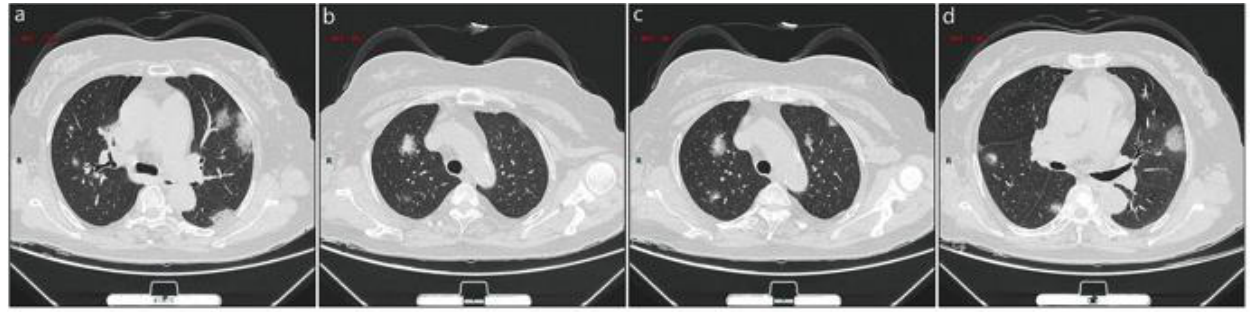
Figure 5: Atypical CT / X-ray imaging manifestation (case 2). A 56 years old female with fever for 3 days. Laboratory test: decreased total protein (54.0 g/L),decreased albumin (35.5 g/L),decreased globulin (18.5 g/L), normal white blood cells (4.87 × 10 9 /L), decreased lymphocytes percentage (10.1%), decreased lymphocytes (0.49 × 10 9 / L), decreased eosinophil count (0 × 10 9 /L)), decreased eosinophil count percentage (0%). Imaging examination: a showed two consolidation nodulesat the center of the lateral segment of middle lobe of the right lung which was surrounded by ground-glass opacities; b showed patchy ground-glass opacity in the anterior segment of the right upper lung with patchy consolidation lesions in it; c showed patchy ground-glass opacities in both lungs with patchy consolidation lesions in it. d showed patchy consolidation in the ground-glass opacities in the middle lobe and dorsal segment of lower lobe of right lung.